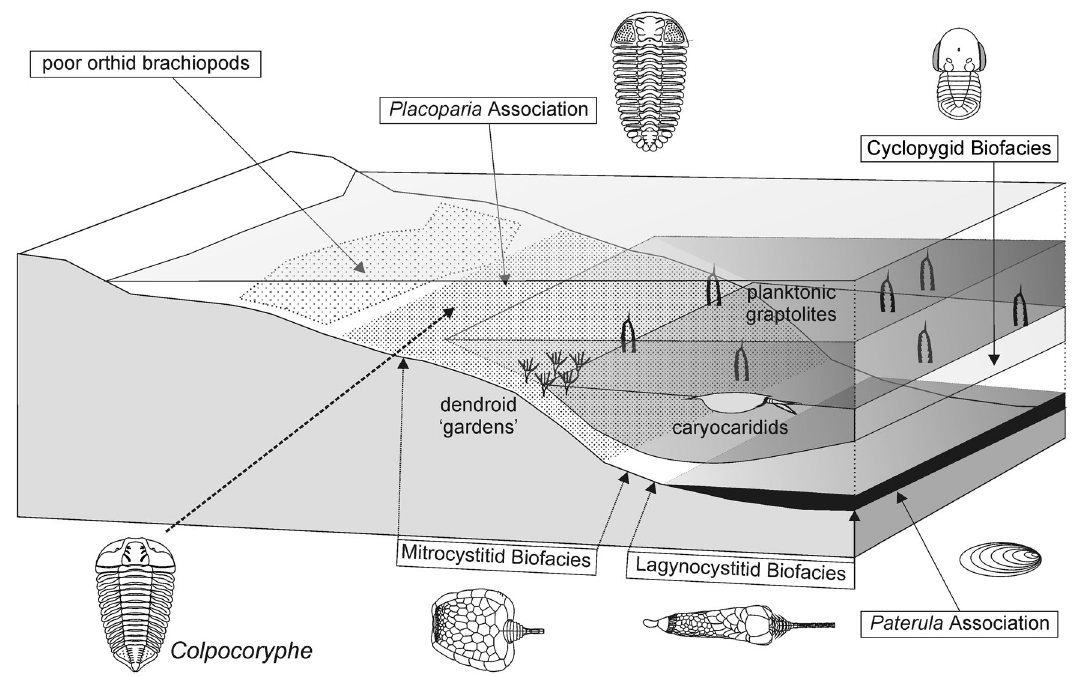
Fig. 2. Sketch showing the distribution of major biofacies associated with the late Darriwilian Šárka Formation. The shallowest part of the basin was inhabited by a sparse orthid brachiopod association. In the offshore direction it was replaced by the Placoparia Association which is characterized by a rich skeletal fauna with trilobites and brachiopods. In the offshore slope settings it grades into a low-diversity atheloptic trilobite association that also includes ‘gardens’ of benthic dendroids. The water column was inhabited by planktonic graptolites and taxa of the poorly diverse Caryocarid and Cyclopygid biofacies. Poorly oxygenated black shales in the central part of the basin were dominated by the Paterula Association. Modified after Fatka & Mergl (2009, fig.